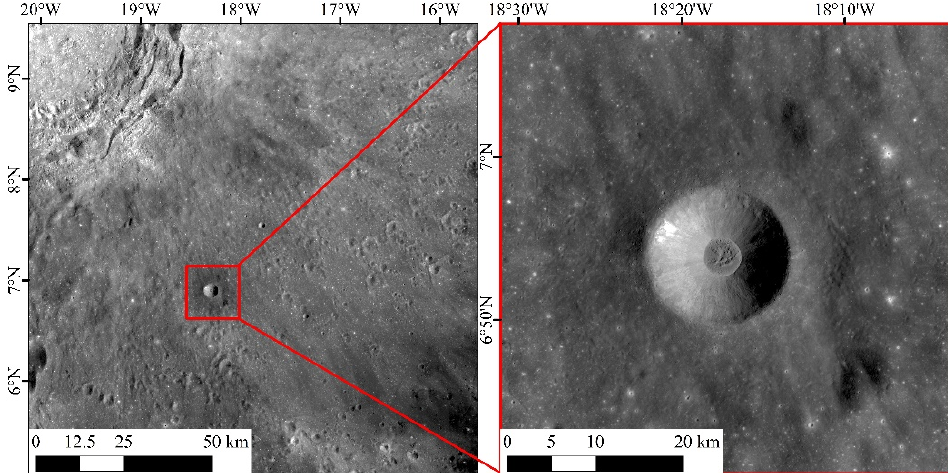
Figure 8. Position of Copernicus H crater on the Kaguya TCortho Mosaic.